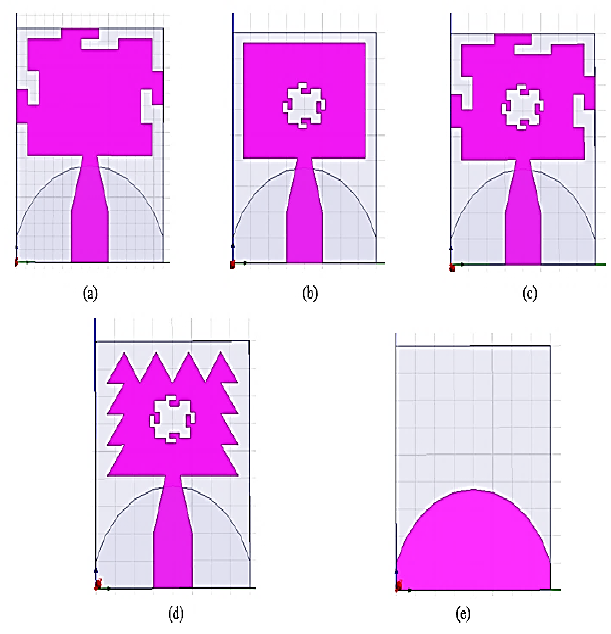
Figure 2: Different proposed models of Antenna (a) Model Model 4 (Bottom